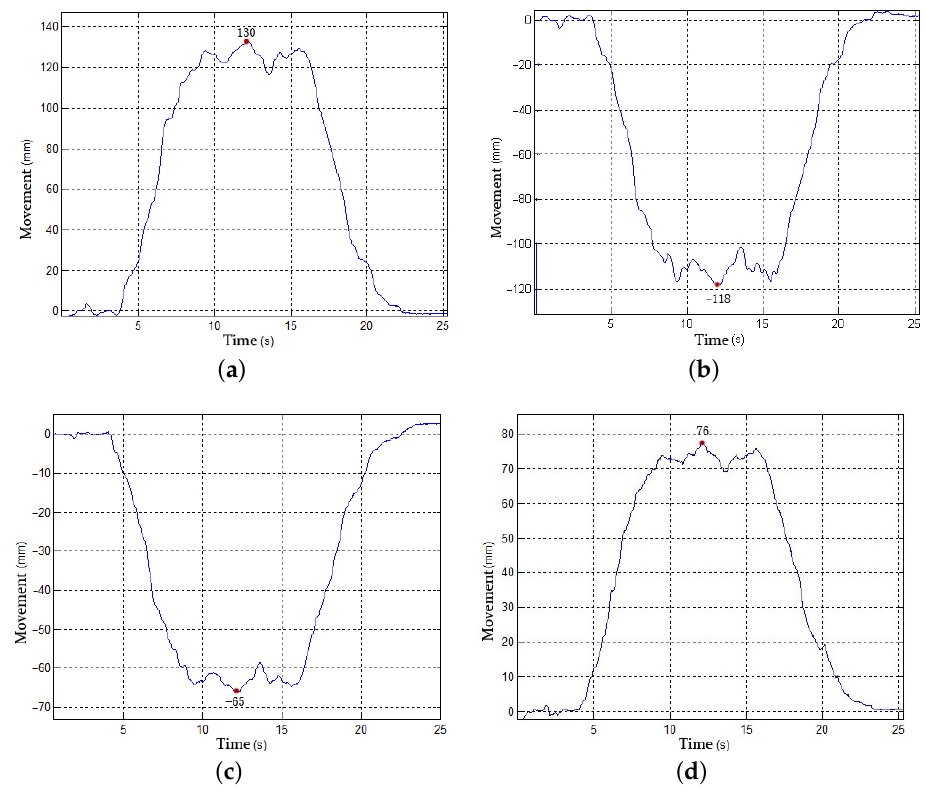
Figure 9. The layout of measuring points and displacement sensors.